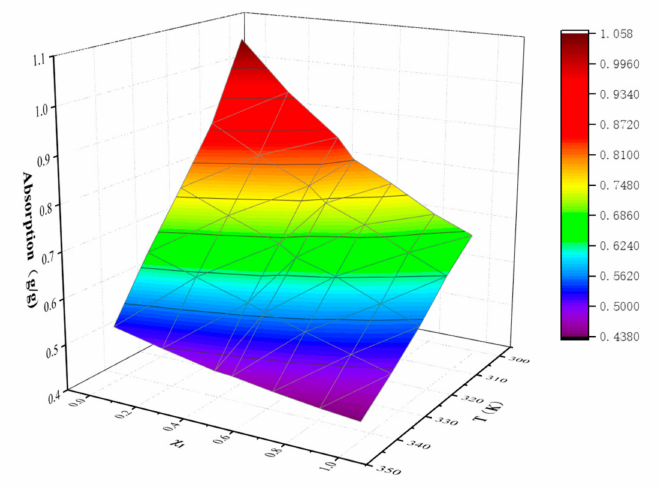
Figure 7. Pseudo-quantitative change of absorption quantities of NO 2 with temperature and compo- sition for the {[EMIM] [TFA] ( χ 1 ) + TEA (1 − χ 1 )} binary